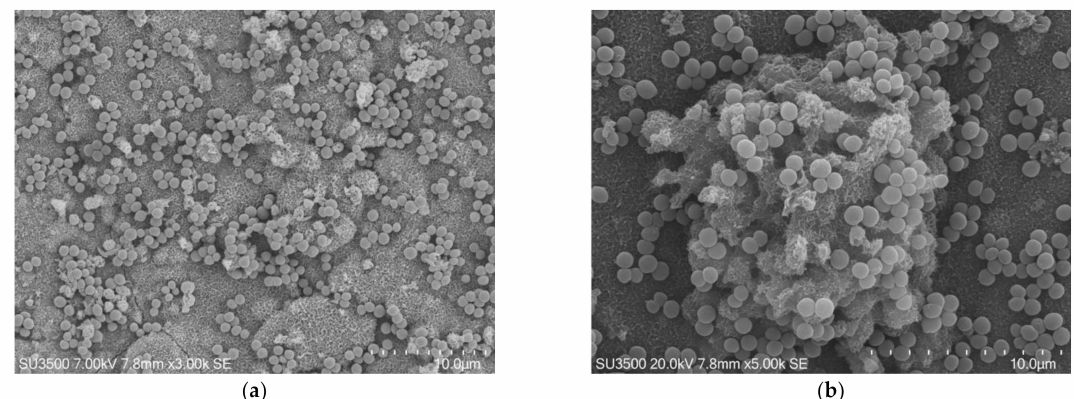
Figure 1. S. mutans prepared by conventional scanning electron microscope (SEM) protocol. ( a ) SEM, 3000 × . S. mutans spherical bacterial cells were scattered on biofilm matrix compact surface. Image was captured from the same sample observed in Figure 1a from [50]; ( b ) SEM, 5000 × . Increasing magnification S. mutans spherical bacterial cells appeared clustered in small groups on the surface of a rough and dense extracellular matrix (Eps).